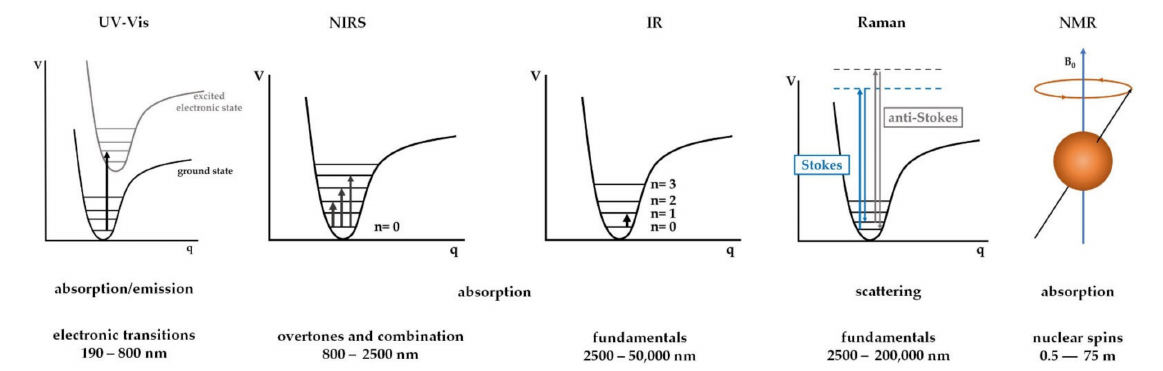
Figure 3. Characteristics of molecular spectroscopy methods (based on Burns et al.